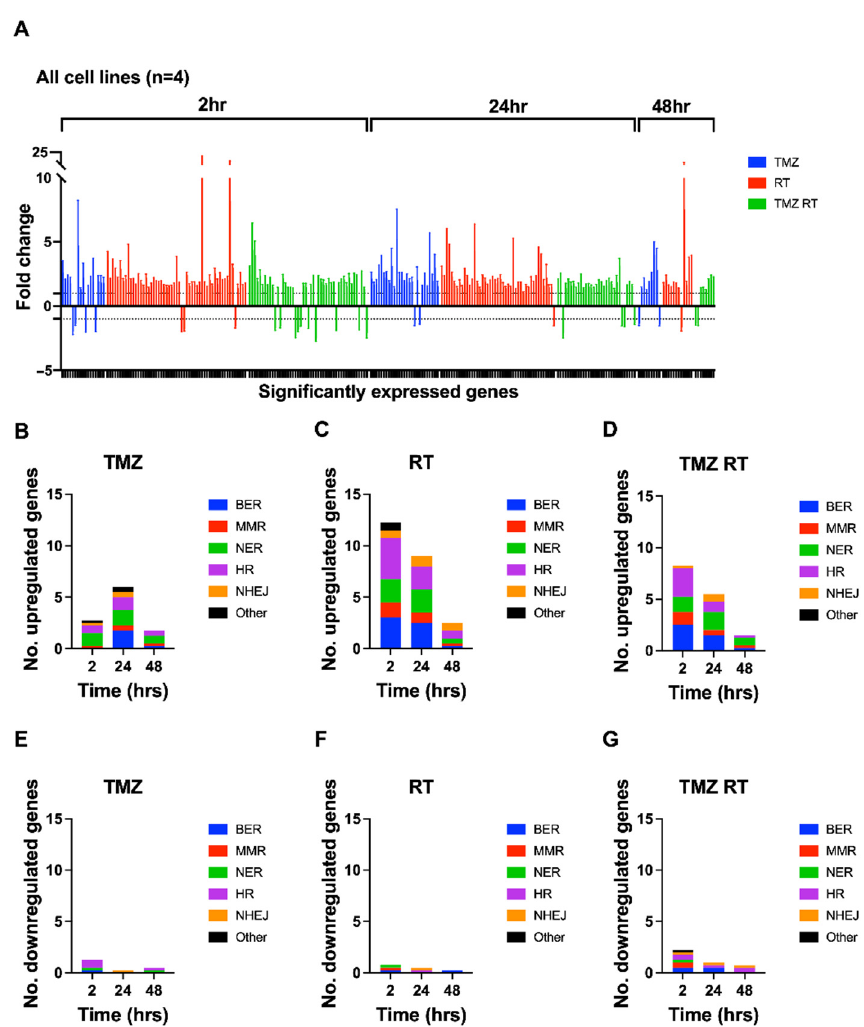
Figure 5. Accumulated frequency and distribution of DEGs across four patient-derived glioblastoma cell lines (FPW1, HW1, SB2b and MN1) in response to treatment. Cell lines were treated with RT (2Gy) and/or TMZ (35µM) before being harvested for RNA extraction at 2, 24 and 48 h after treatment. Quantitative PCR using a Custom TaqMan array card was undertaken to assess mRNA expression of 84 DDR genes. ( A ) Fold changes ( ± SEM) represent the sum total of DEGs across all cell lines, treatments (TMZ- blue; RT—red; TMZ + RT—green), and time points. Positive fold-changes (>1) represent upregulated genes and negative fold-changes (< − 1) represent downregulated genes, while the area between 1 and − 1 represents baseline expression. To view genes and their fold-changes in order of ( A ), see Table S5. ( B – G ) The average numbers of upregulated or downregulated genes across all cell lines for TMZ- ( B , E ), RT- ( C , F ) and TMZ + RT- ( D , G ) treated cells are graphically shown and represent the proportion of pathways that the DDR genes belong to at given time points after treatment. DDR pathways for each gene are depicted in Table S2. BER—blue; MMR—red; NER—green; cell cycle—purple; HR—orange; NHEJ—black; other—brown.